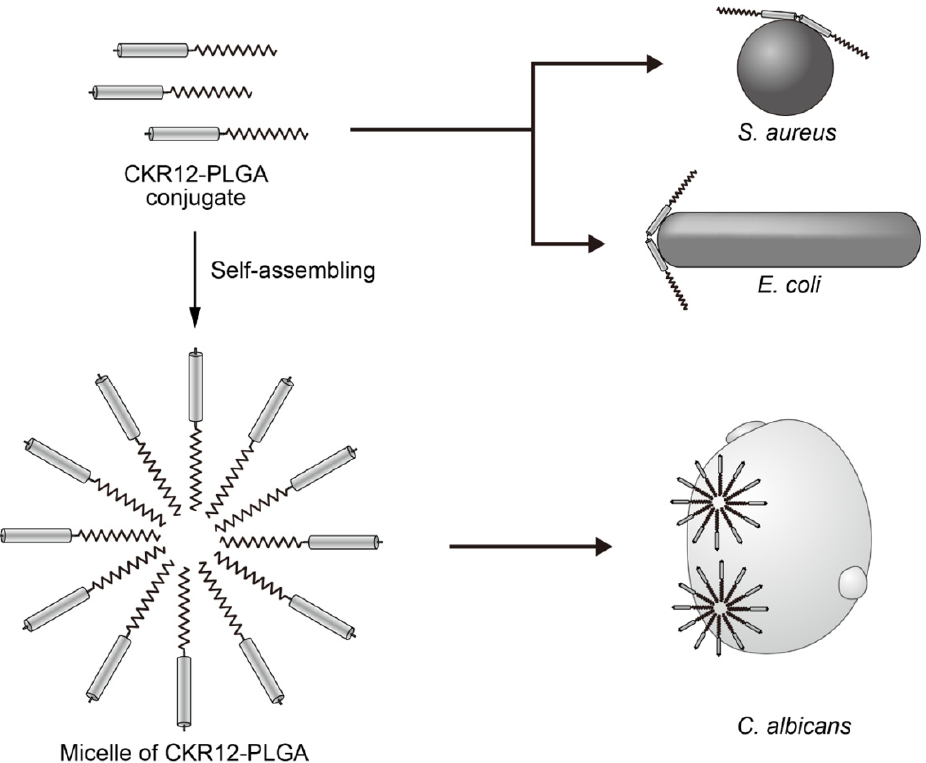
Figure 6. Schematic mechanisms of individual and self-assembled micelles of CKR12-PLGA against S. aureus , E. coli , and C. albicans .